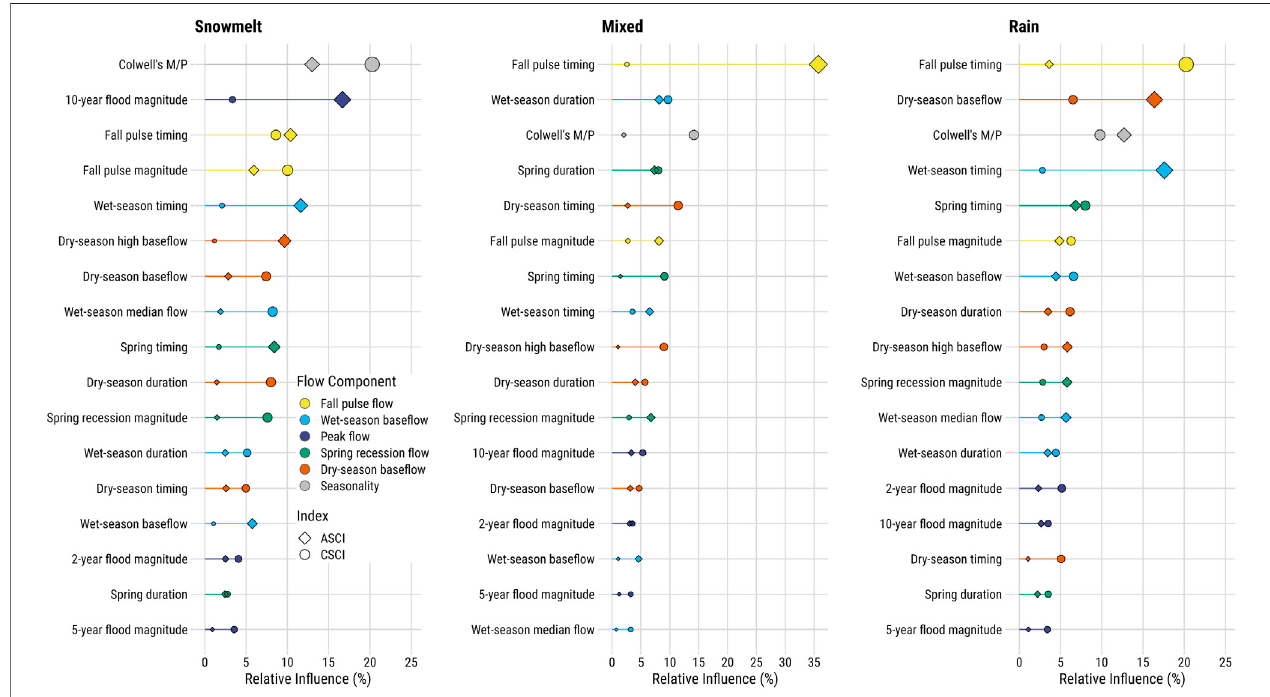
FIGURE 8 | Relative importance of functional fl ow metrics in boosted regression tree models assessing fl ow alteration relative to ASCI and CSCI scores by stream classi fi cation (Patterson et al., 2020). Relative in fl uence values were calculated using a mean-square error (MSE) approach, which determines those variables with the largest average reduction in MSE. Functional fl ow metrics are described in Table 1